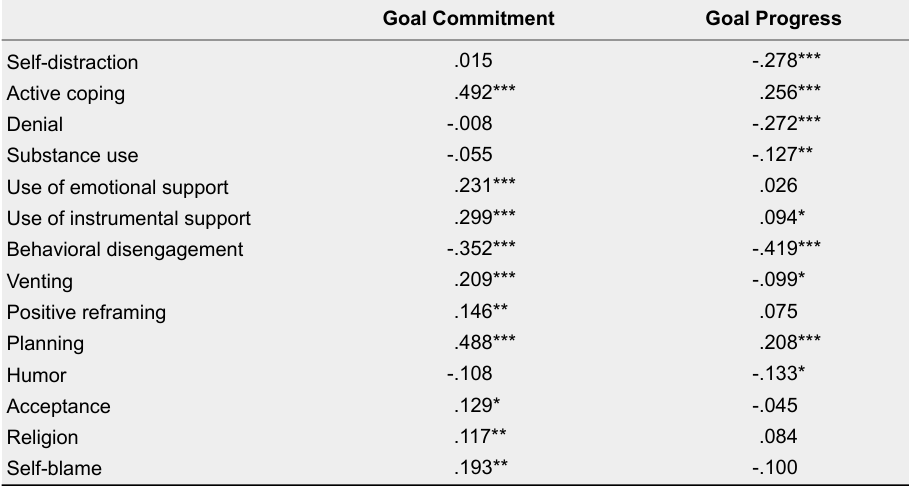
Correlations of Coping Responses With Goal Commitment and Progress